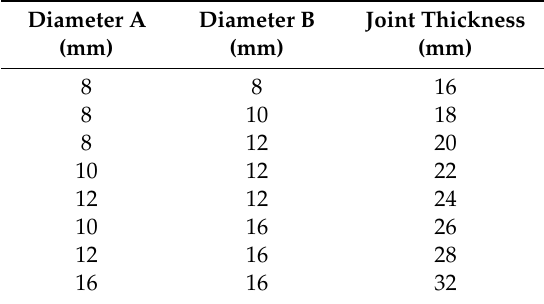
Table 1. Combinations of different diameters.